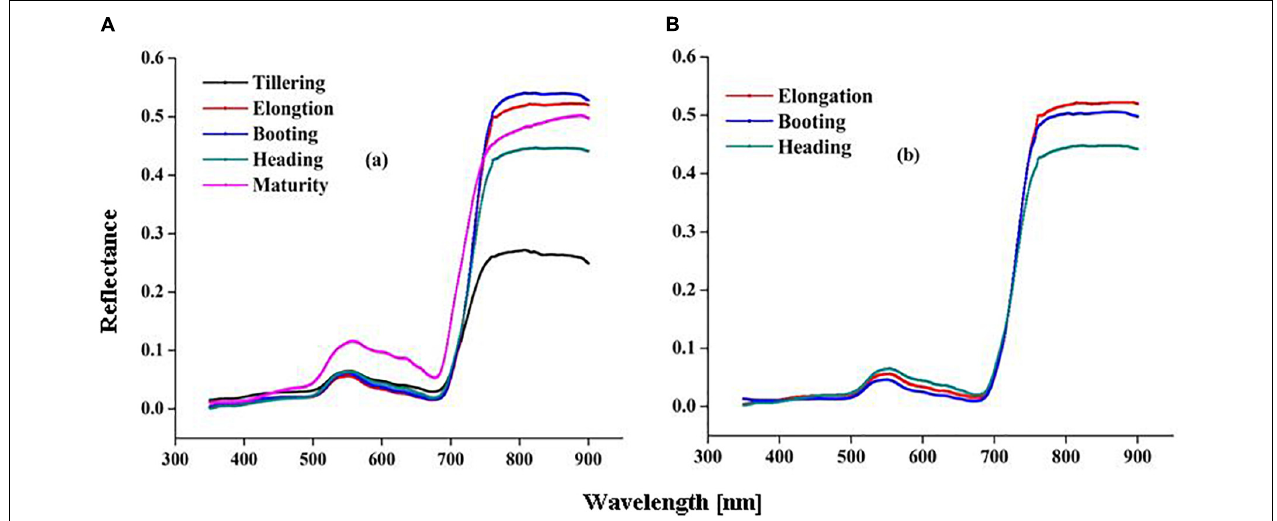
Frontiers in Plant Science |